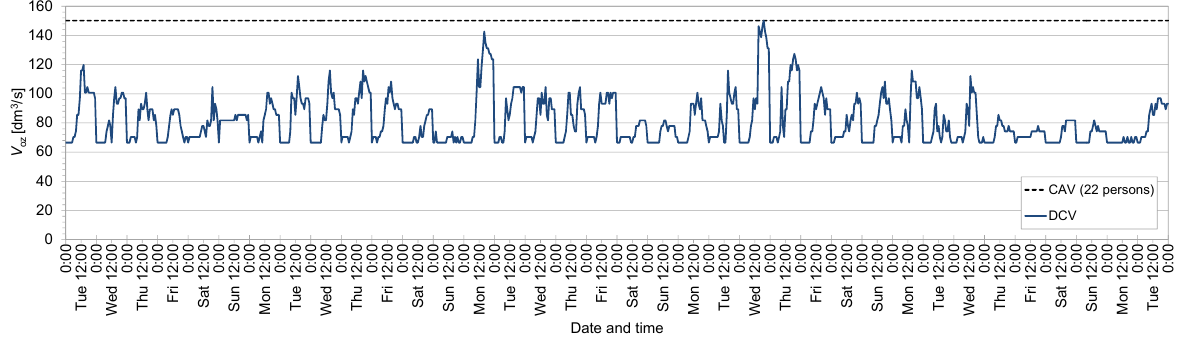
Figure 6. Modeled hourly zone outdoor airflows ( V counting sensor based DCV and CAV.